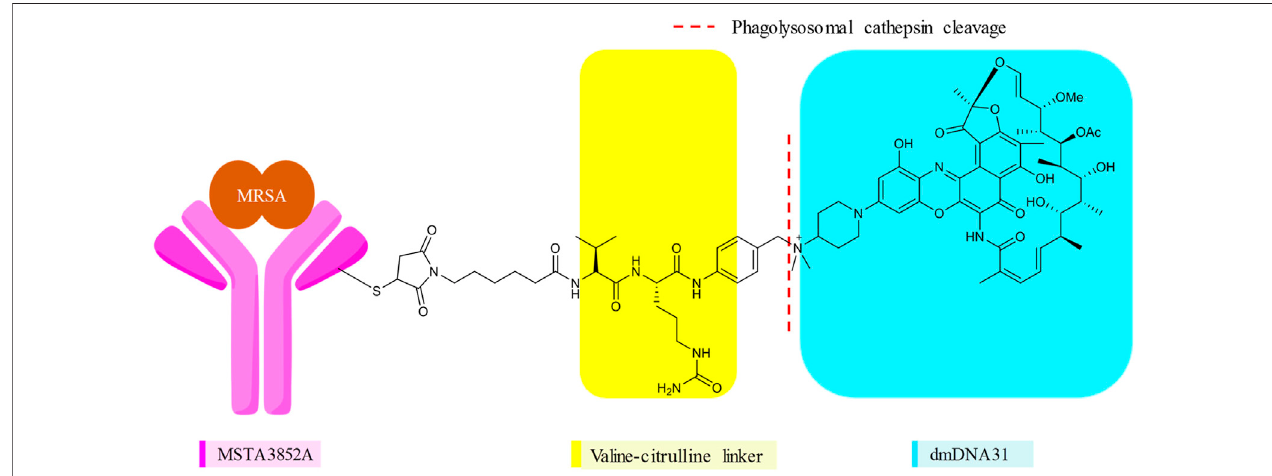
FIGURE 6 | Monoclonal antibody, linker, and the antibiotic of DSTA4637S ( 23 ).